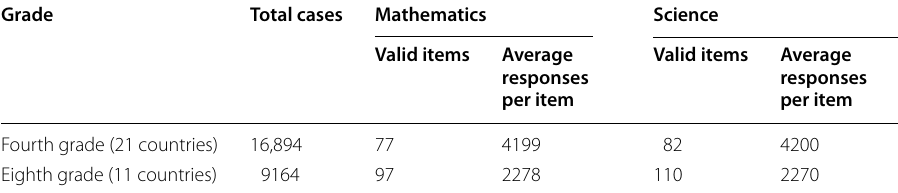
Counts reflect resulting sample sizes after deleting problematic data and expected non ‑ invariant items